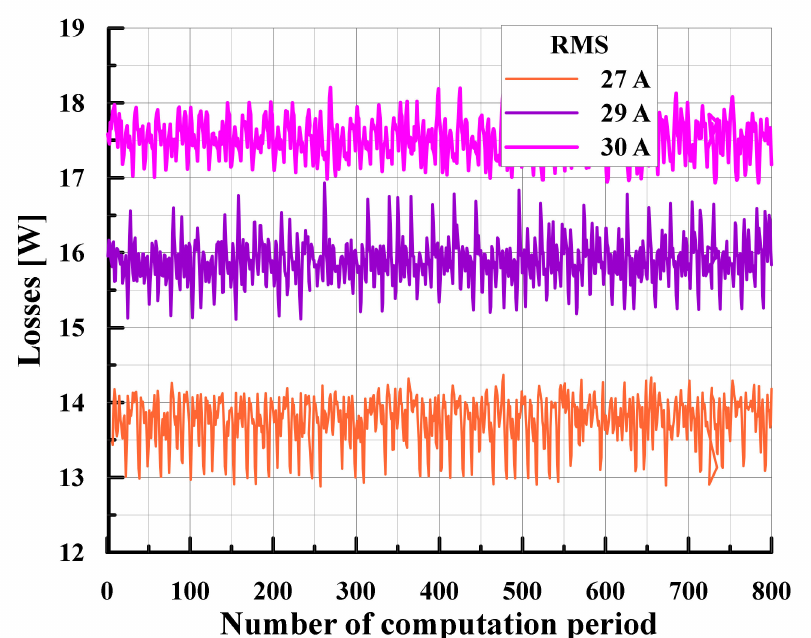
Figure 8. Losses for BLAC current case versus computation period